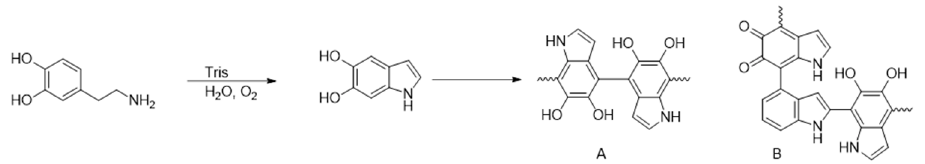
Figure 1. Possible mechanism of polydopamine formation and possible structures ( A , B ) of polydopamine [32].